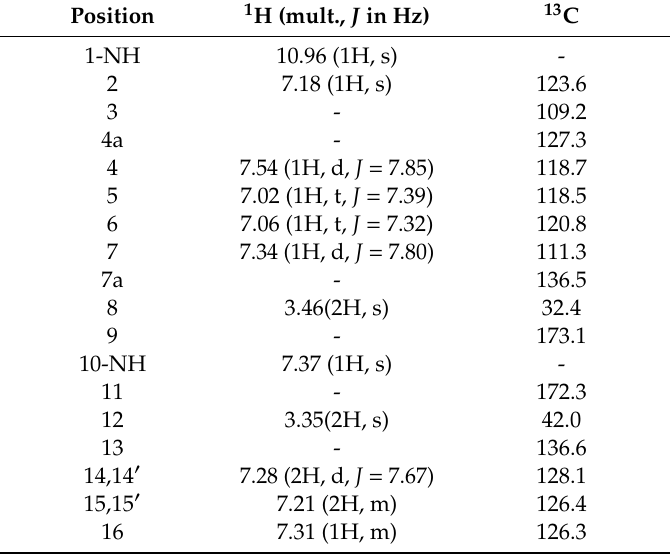
Table 1. 1 H and 13 C NMR assignments of legonimide 1 (600MHz, 298K, DMSO- d 6 ).